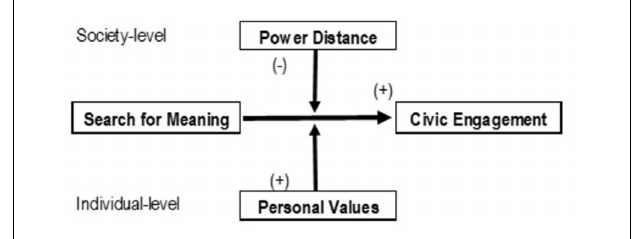
FIGURE 1 | Illustration of hypothesized